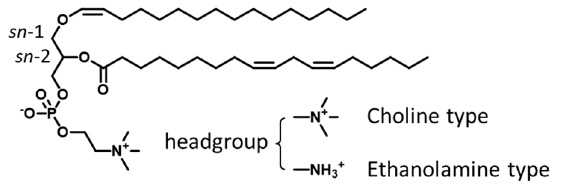
Figure 1. Structure of plasmalogen (taking choline plasmalogen p16:0/18:2n-6 as an example).